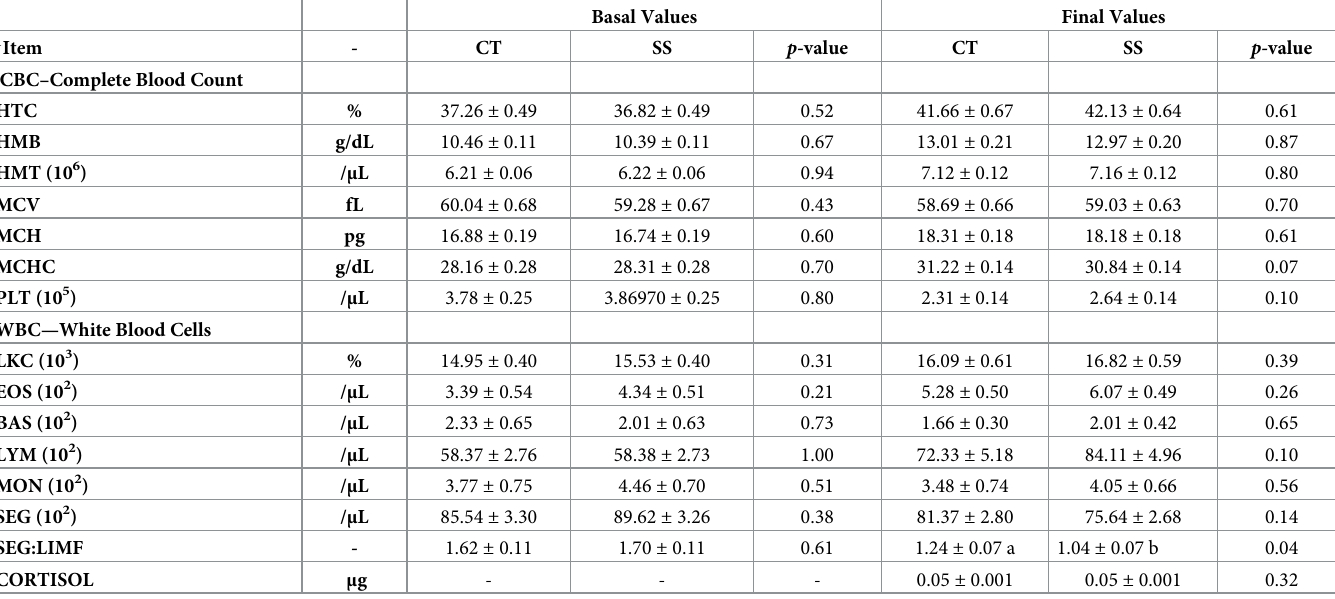
Table 8. Initial and final average blood count (mean ± SE) and cortisol samples (mean ± SE) of growing and finishing pigs according to treatment. Basal